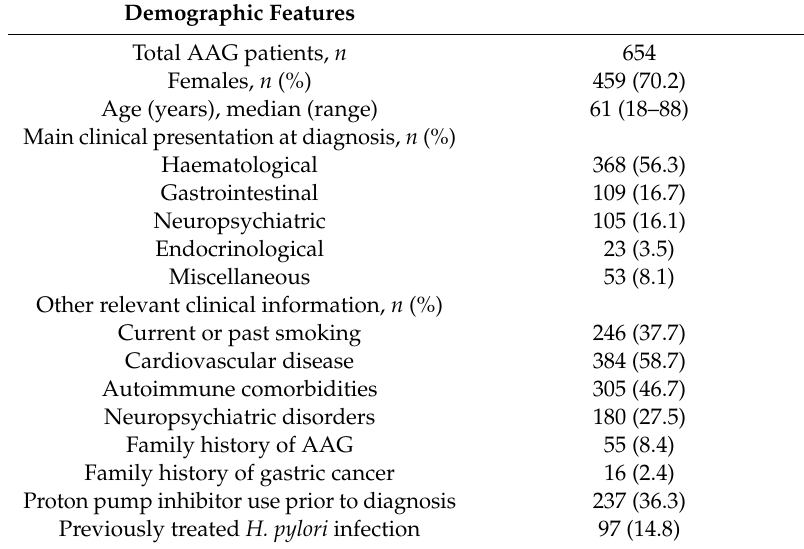
Figure 1. Flowchart of the study. Patients were excluded as per study design. Of the 654 included patients, cell blood count data of 181 (88 anaemic, 93 not anaemic) patients at one-year follow-up were reported. Abbreviations: AAG, autoimmune atrophic gastritis; Hp, H. pylori . Table 2. Main demographic and clinical features of patients with autoimmune atrophic gastritis